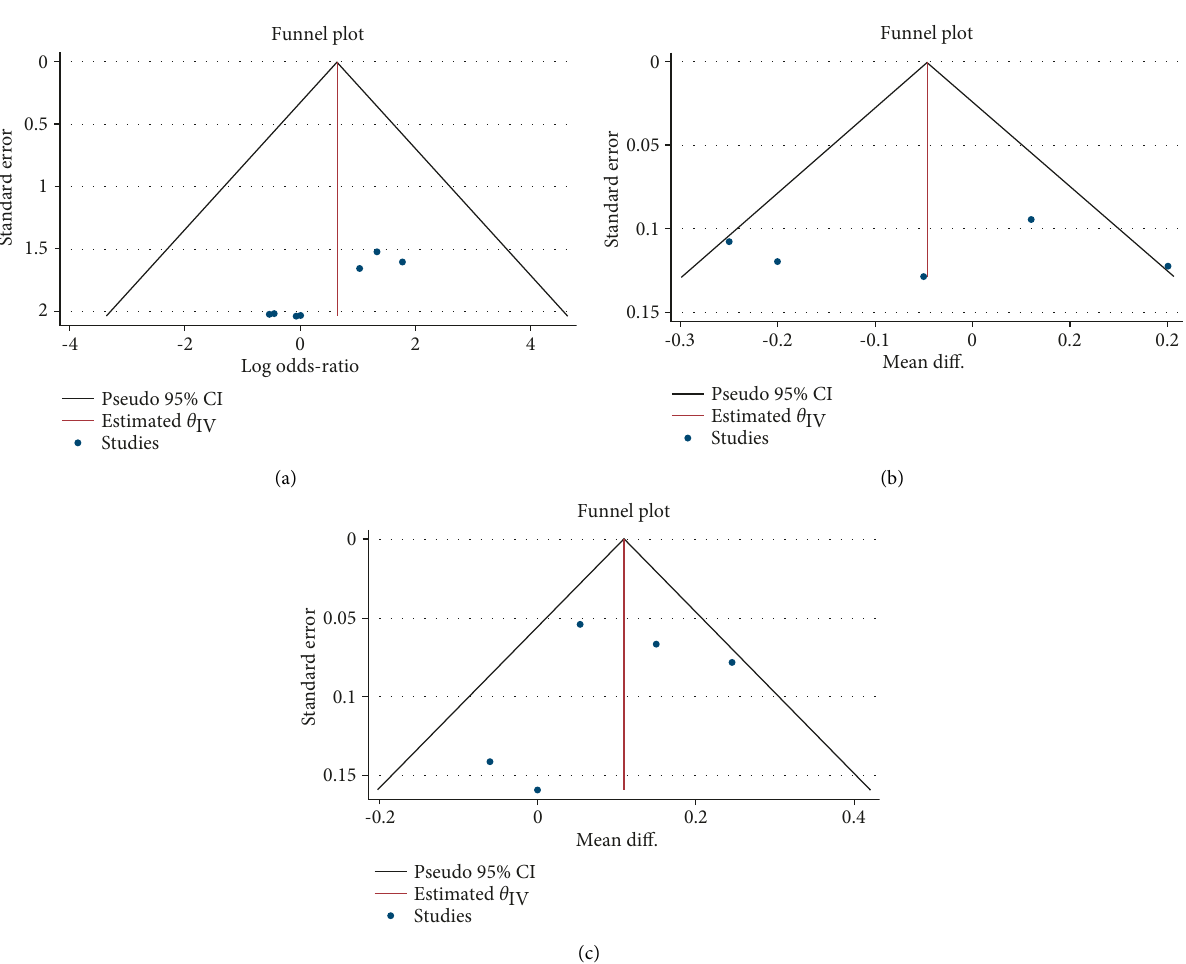
Figure 6: Funnel plot analysis of primary outcomes. (a) MH closure rate. (b) Preoperative BCVA in logMAR. (c) Postoperative BCVA in